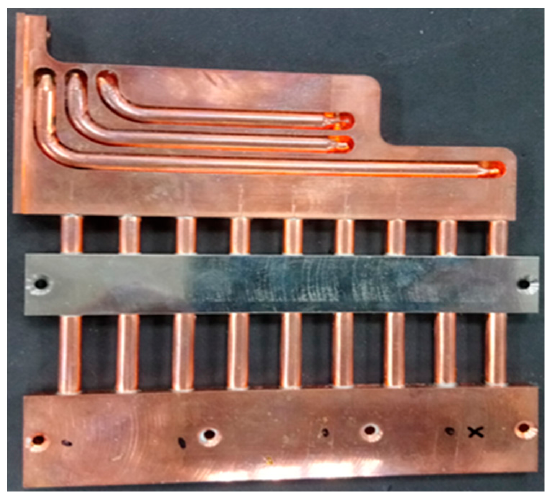
Figure 13. Specimen Type I.